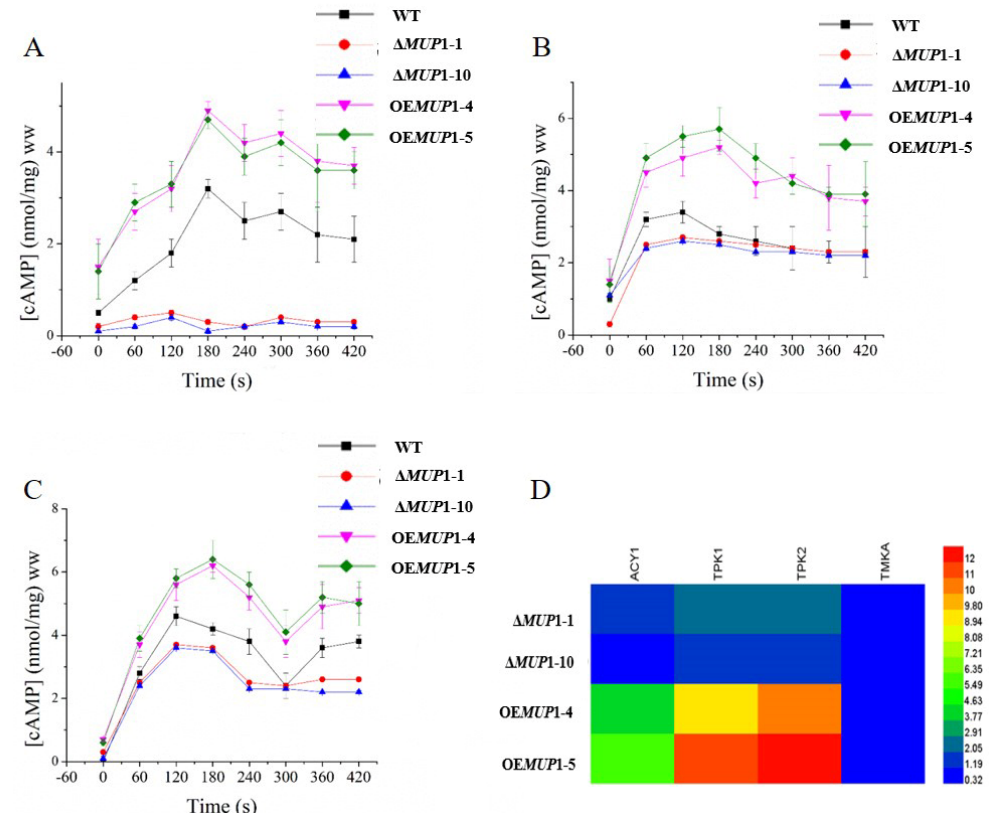
Figure 4. Methionine-dependent cAMP production depends on Mup1 and can be induced by SAM and spermine under the same conditions. cAMP production in response to ( A ) methionine, ( B ) SAM and ( C ) Spermine. The ww on the y-axis is the wet weight. ( D ) Expression of MAPK and cAMP signaling pathway genes in mutant strains compared to WT.